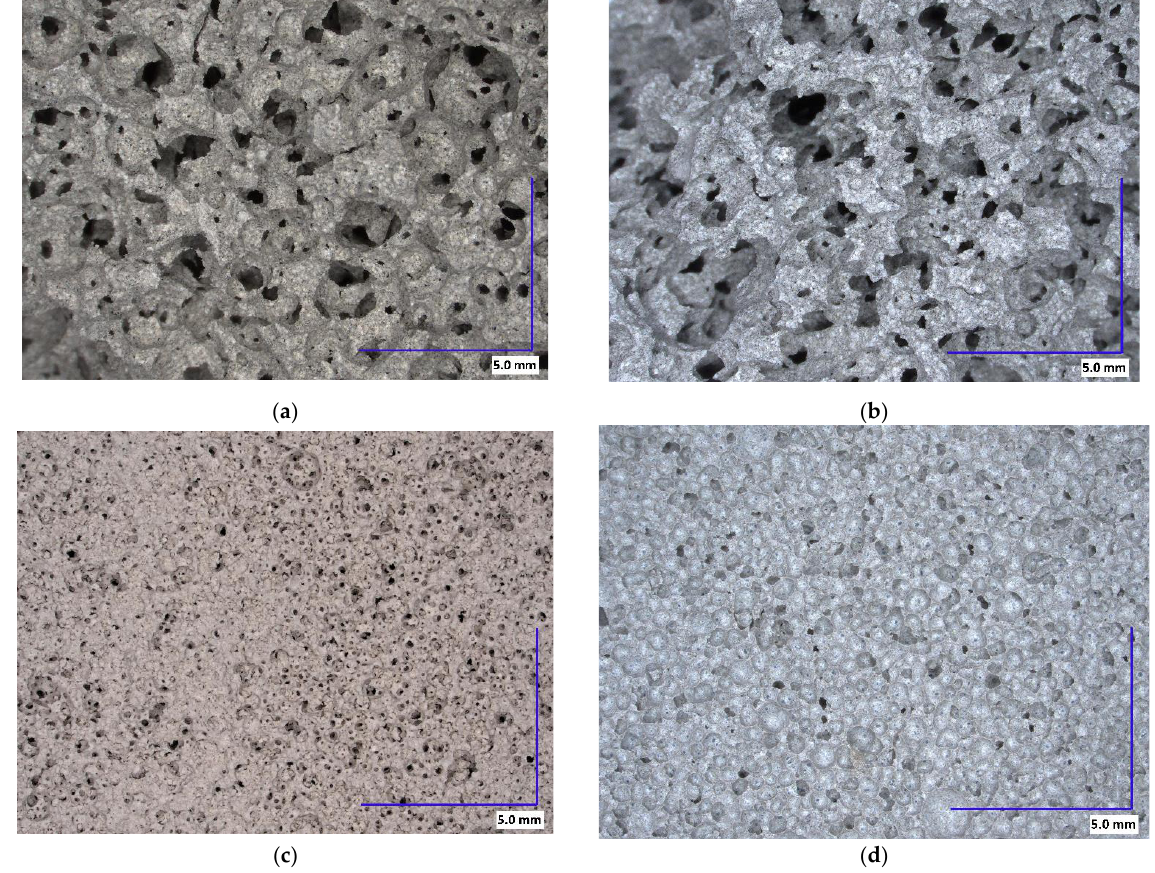
Figure 7. Microscopic photos of the foam concrete with an average density of 300 kg/m 3 : ( a ) OPC/metakaolin/synthetic foaming agent; ( b ) OPC/CFA/synthetic foaming agent; ( c ) CSA/metakaolin/synthetic foaming agent; ( d ) OPC/metakaolin/protein-based foaming agent (the scale size is shown in the bottom right corner of each